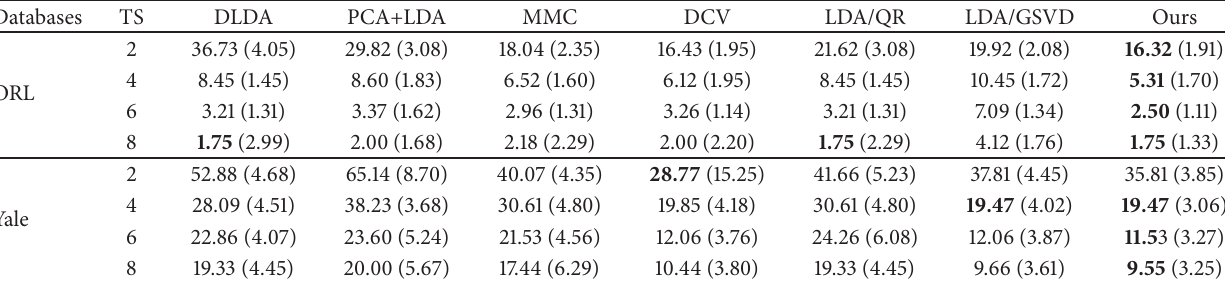
Table 2: Performance comparisons (%) of some methods on face